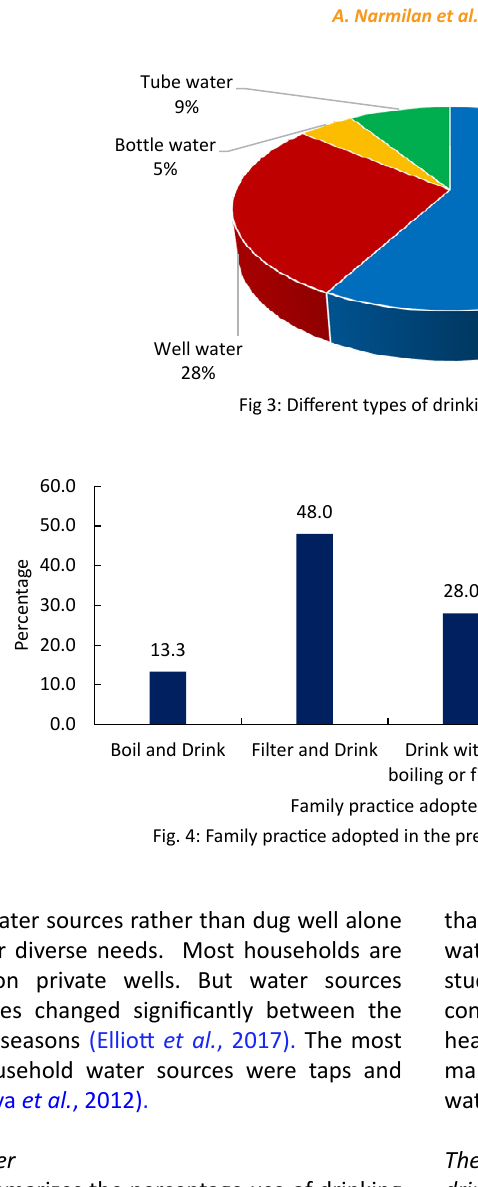
Fig. 4: Family practice adopted in the preparation of drinking water